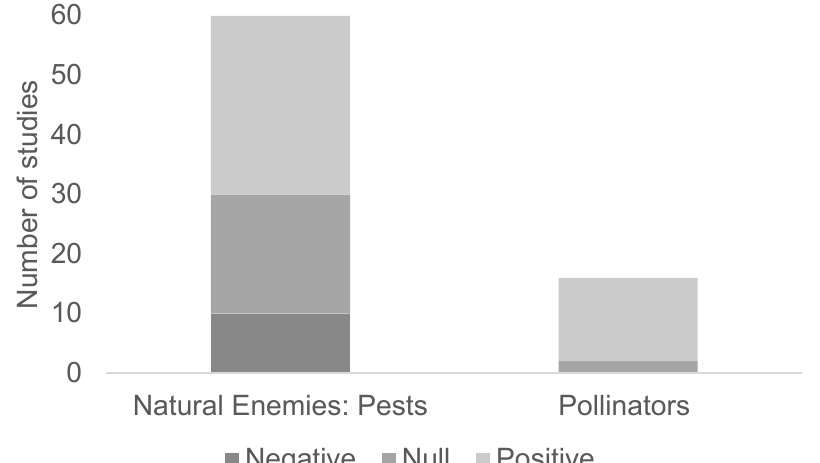
Figure 4. Summary of the studies in Tables 2 and 3 showing the numbers of floral enhancement studies in fruit crops that recorded negative, null, or positive impacts on fruit pests and/or their natural enemies (densities, fruit damage, number of pesticide applications), and on pollinators, including fruit production. NB: data not statistically analyzed.